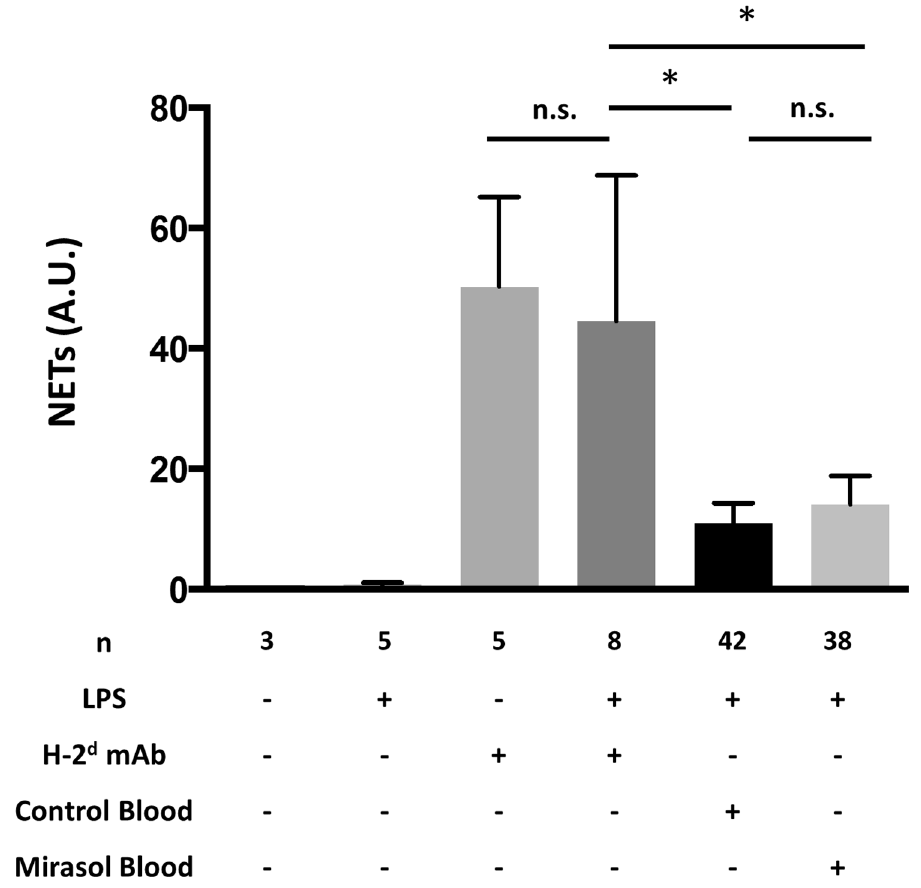
Fig 5. Presenceof NETs in plasma after TRALI or human whole blood transfusion. Plasma NETs in BALB/c SCID mice challengedwith no intervention,LPS priming, H-2 d mAb alone, LPS + H-2 d mAb, or LPS priming and either control or